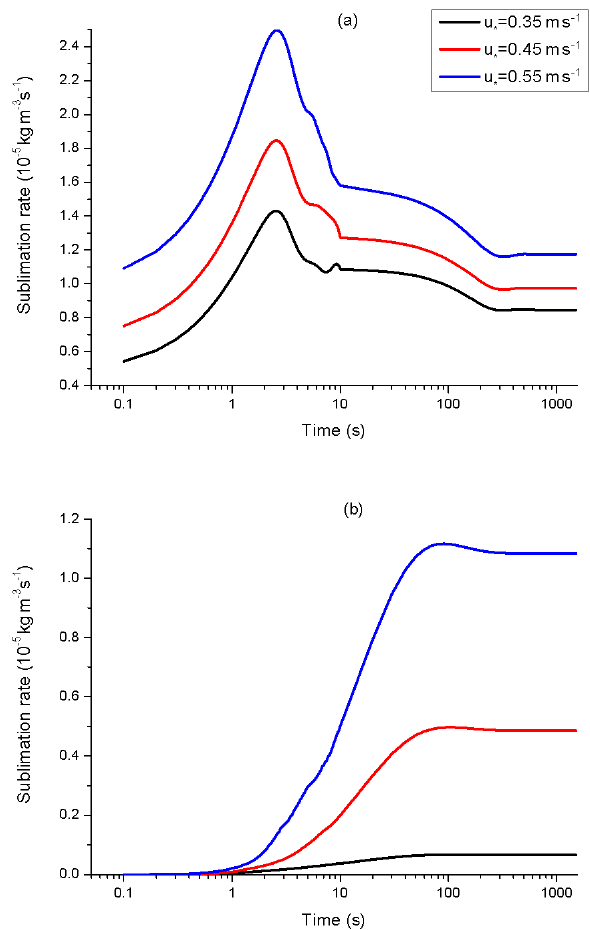
Figure 9. Temporal evolution of saltation and suspension sublima- tion rates: (a) saltating particles; (b) suspended particles.